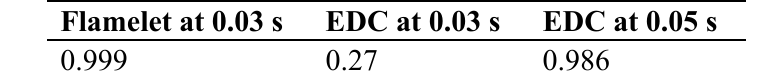
Table 5. Combustion